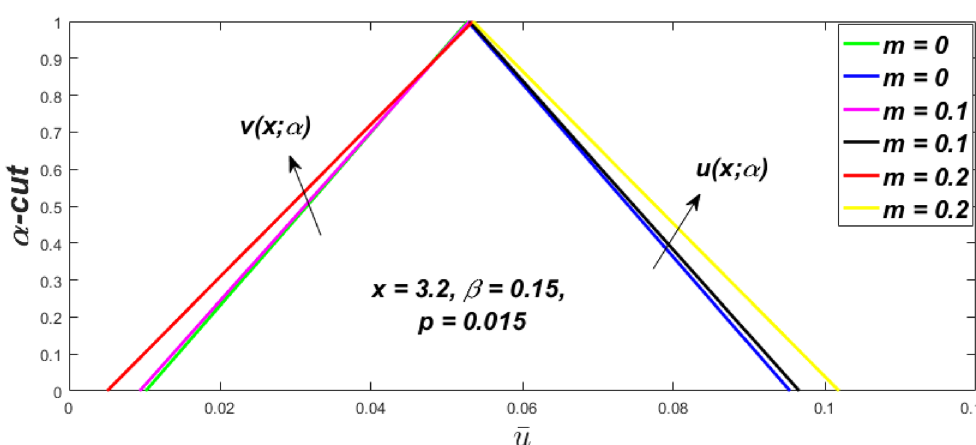
Figure 41. Triangular MF of the fuzzy velocity for the impact of m.